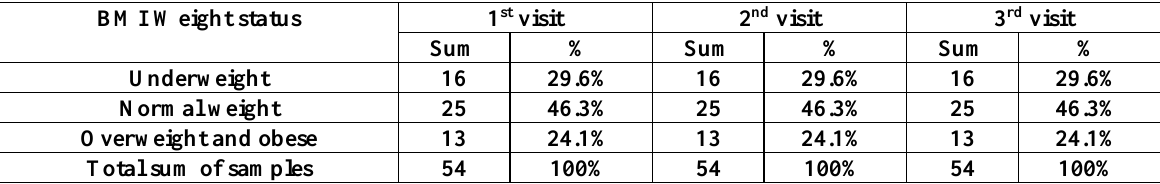
Table 1 : Distribution (in numbers and percentages) of the study subjects weight status through the three visits